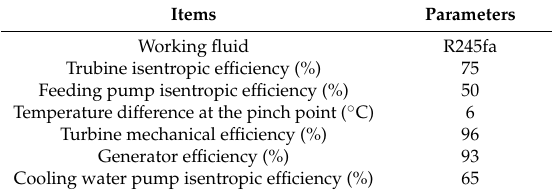
Table 2. System parameters used in the simulation of organic Rankine cycle (ORC) system.